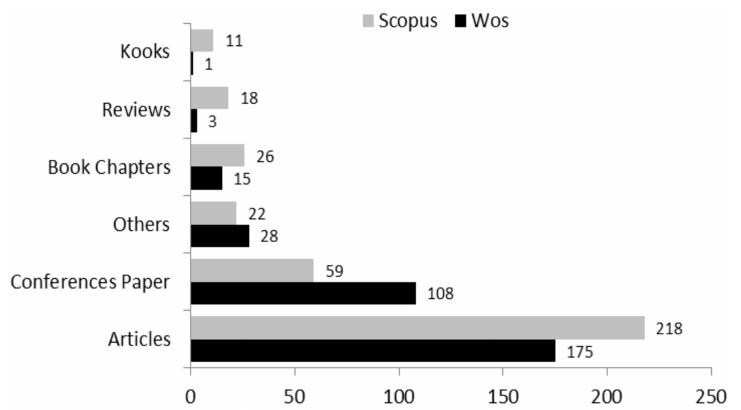
Figure 1. Classification of the documents located in WoS and Scopus on Sustainable Water Resources Management. Source: The authors’ own